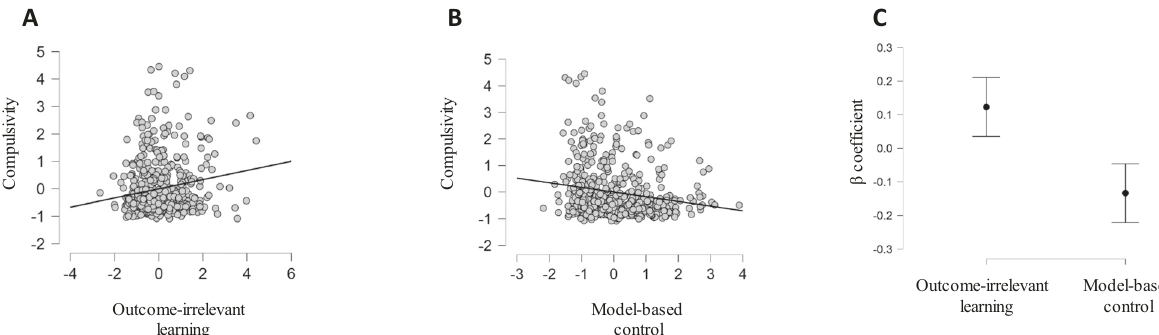
Fig. 4 Association of outcome-irrelevant learning and model-based control with compulsivity. A Scatterplot showing the association between outcome-irrelevant learning and compulsivity. B Scatterplot showing the association between model-based control and compulsivity. C Posterior mean coef fi cients with 95% credible intervals taken from a Bayesian regression analysis exploring the effects of outcome-irrelevant learning and model-based control on compulsivity. Overall, the results show that outcome-irrelevant learning is positively related to compulsivity, even when controlling for the impact of model-based control (note that estimates are presented as standardized scores. Outcome-irrelevant learning estimates re fl ect the compound scores across fi ve closely related task-based estimates, model-based control estimates re fl ect the compound scores across three closely related task-based estimates, and compulsivity re fl ects a factor that mainly loaded on self-report items of washing, checking, ordering, and